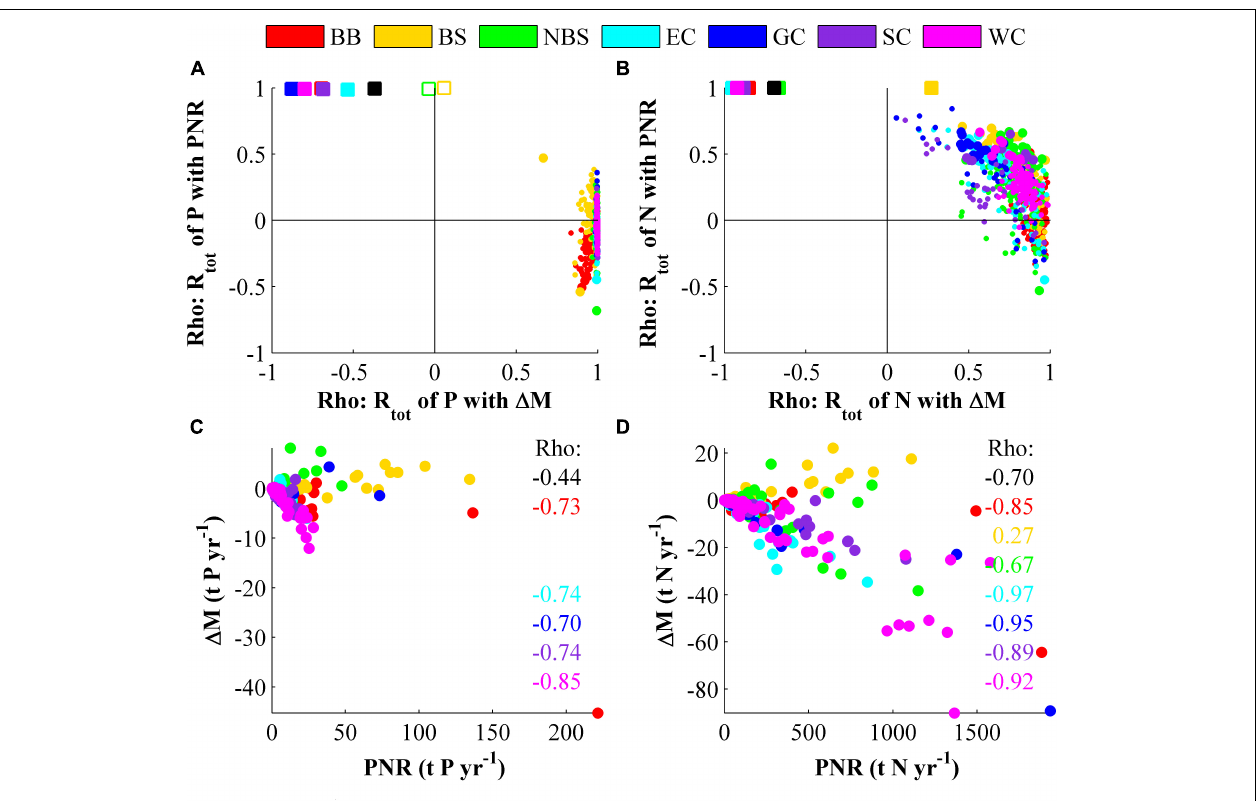
FIGURE 8 | Association strength (Spearman’s rank correlation, Rho ) of total retention ( R tot ), internal losses ( PNR ) and changes in nutrient storage ( (cid:49) M ). (A,B) Each marker represents a data-set for which the association strength of R tot to PNR and (cid:49) M has been calculated. The correlations in data-sets consisting of inter-annual variations within basins are shown as colored dots and correlation of 20-years averages are shown as colored squares. Smaller dots and open or missing squares denote that the correlation was insignificant ( p > 0.05) for one correlation coefficient. (C,D) Show 20-year averaged values from each basin. Statistically significant ( p < 0.05) Rho values are printed in the